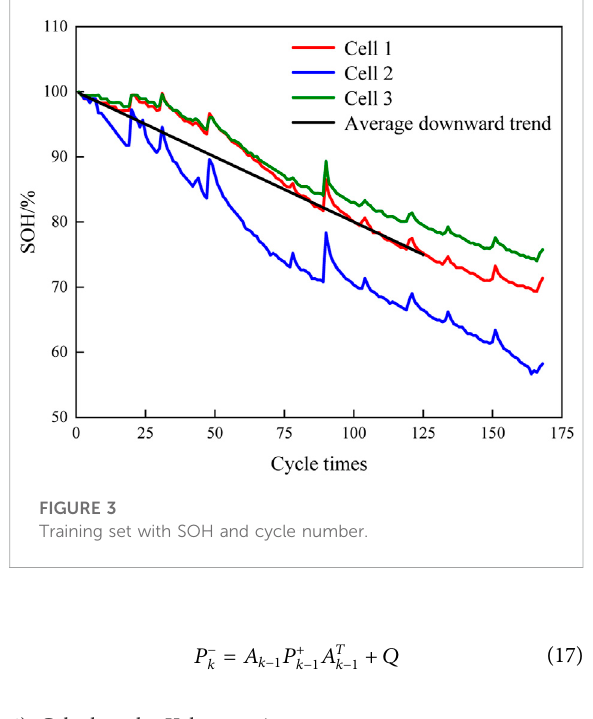
FIGURE 3 Training set with SOH and cycle